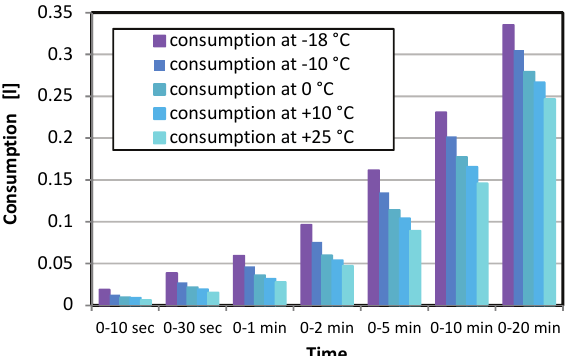
Fig. 1. The amount of fuel consumed by LANCIA Ypsilon (SI)